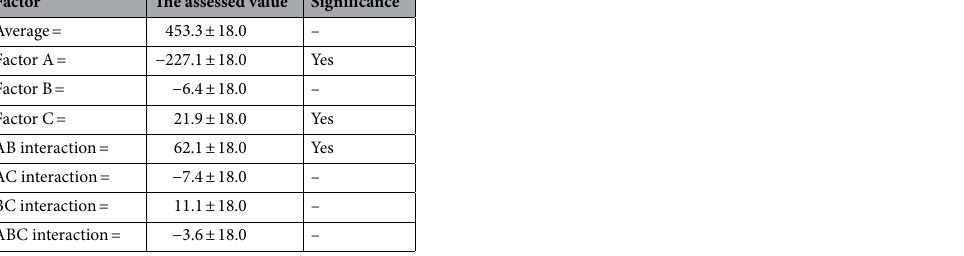
Table 4. The effect values of 2 3 factorial designs with respect to postrefining pulp freeness variables.